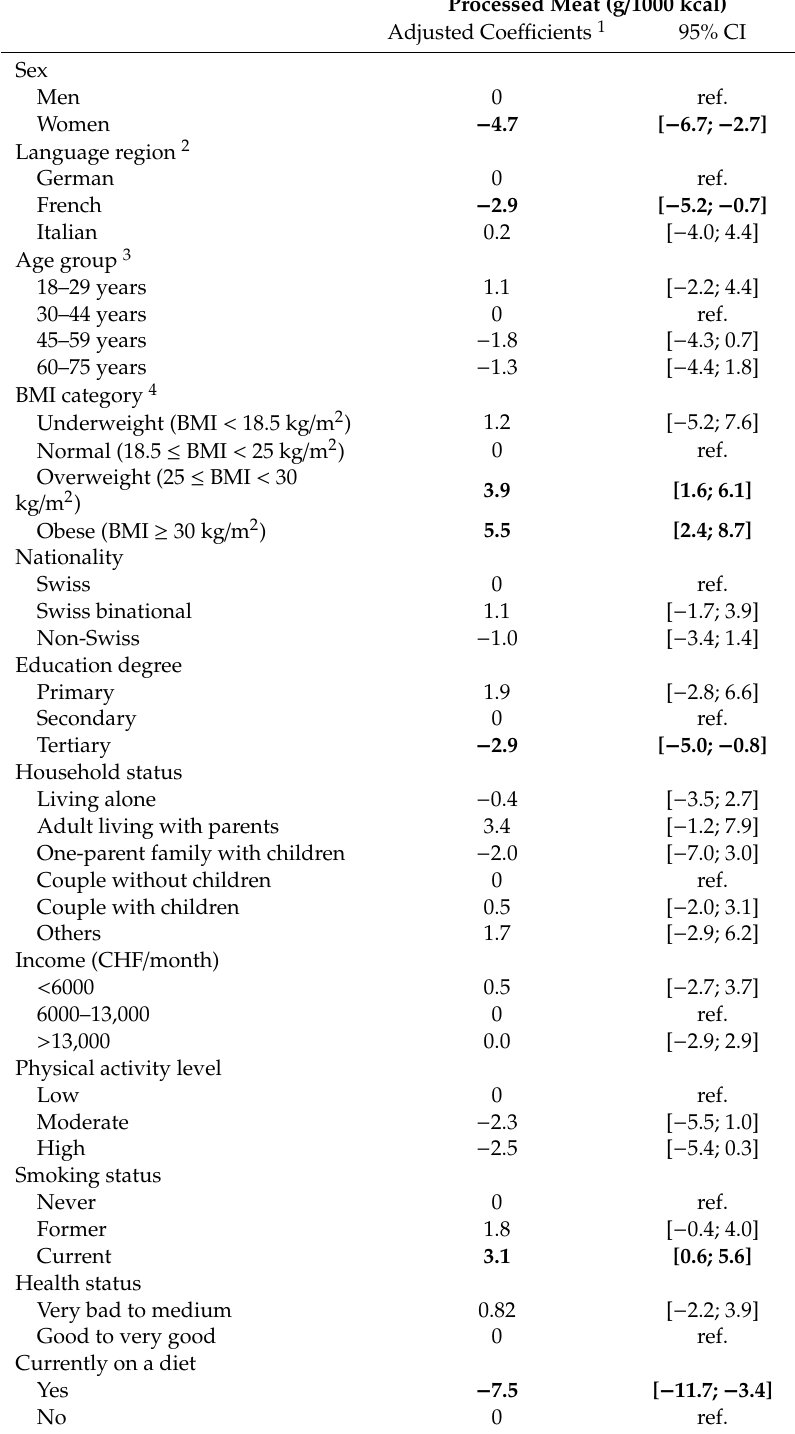
Table 4. Associations between processed meat intake and sociodemographic and lifestyle factors, by multivariable linear regression analyses ( N =